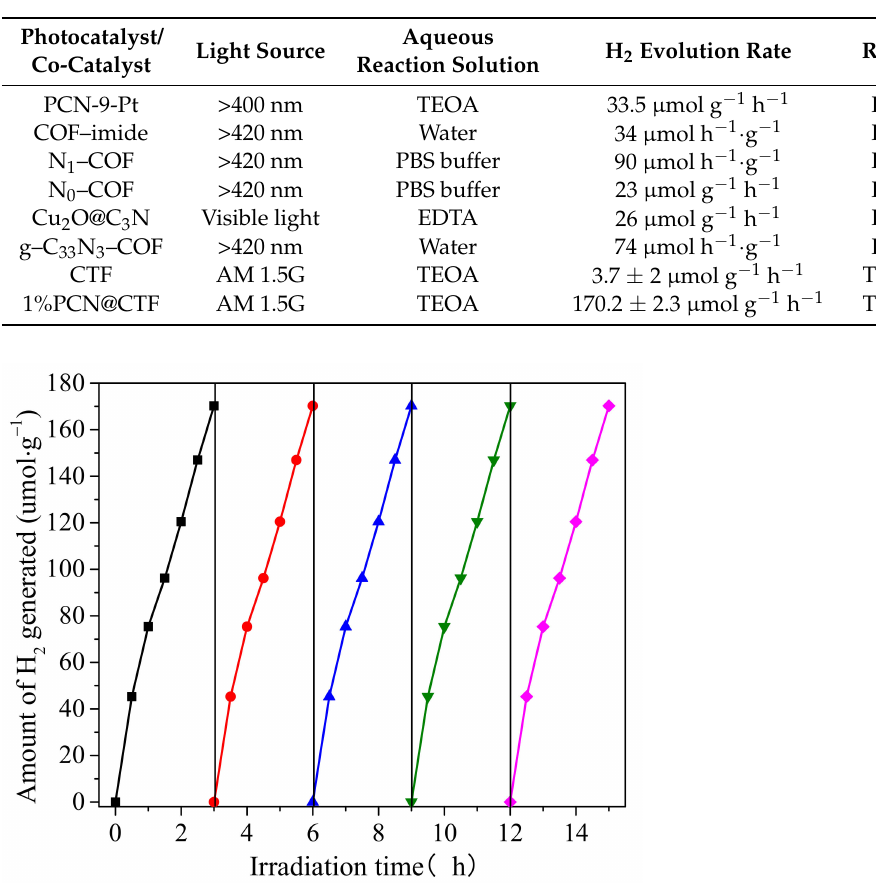
Figure 10. Photocatalytic hydrogen evolution reaction using CTF and x %PCN@CTF under light il- lumination. Table 1. A comparison of the hydrogen evolution performance of PCN@CTF with other graphite-like carbon nitride materials.